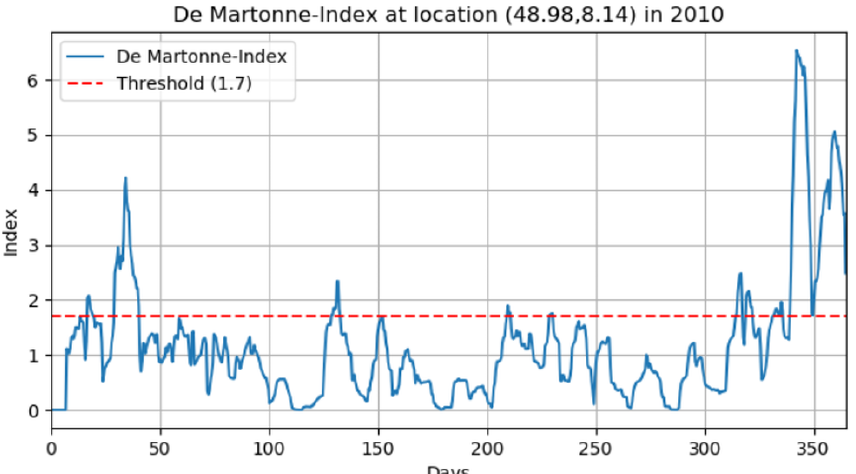
Figure G1. An example of the time series of the weekly De Martonne index at (48.98, 8.14). A threshold of 1.7 is determined, above which precipitation is considered to be